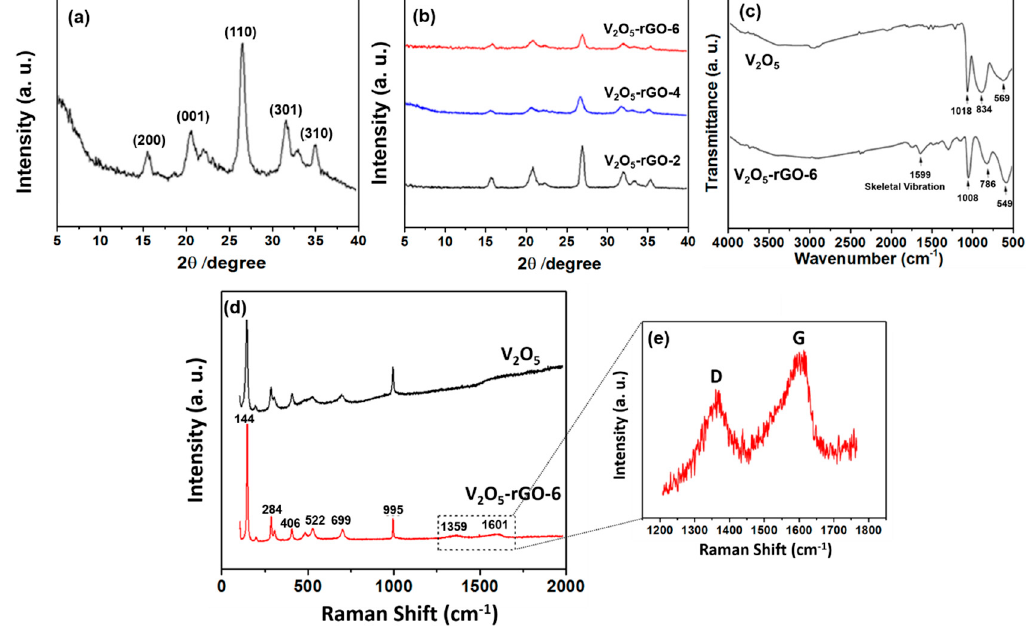
Figure 4. ( a ) XRD patterns of the V 2 O 5 aerogel; ( b ) XRD patterns of the V 2 O 5 -rGO hybrid aerogels with varying weight compositions; ( c ) FTIR spectra of the V 2 O 5 and V 2 O 5 -rGO-6 hybrid aerogels; ( d , e ) Raman spectra of the V 2 O 5 aerogel and the V 2 O 5 -rGO-6 hybrid aerogel.